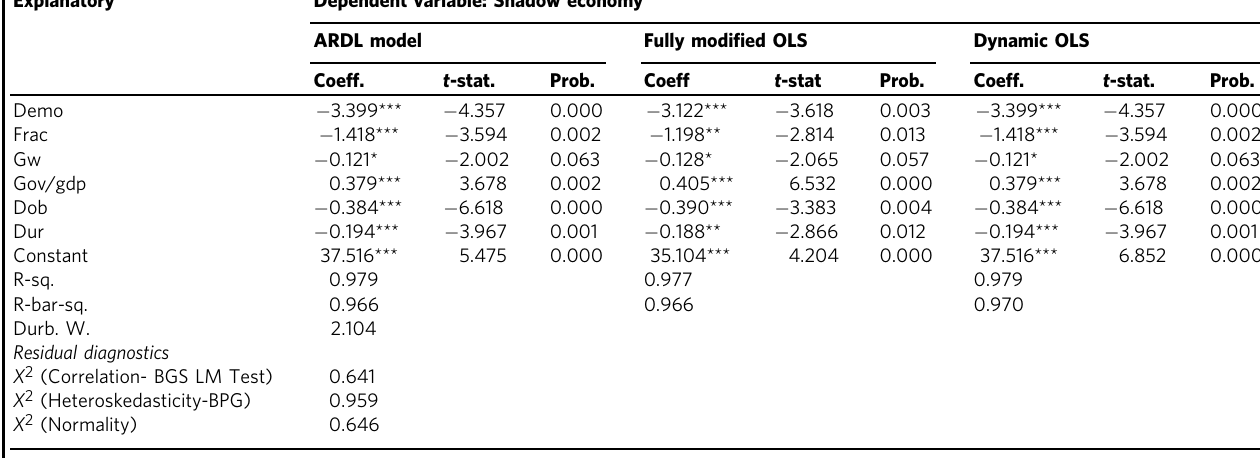
Table 3 Long run relationship between shadow economy and institutionalized democracy. Explanatory